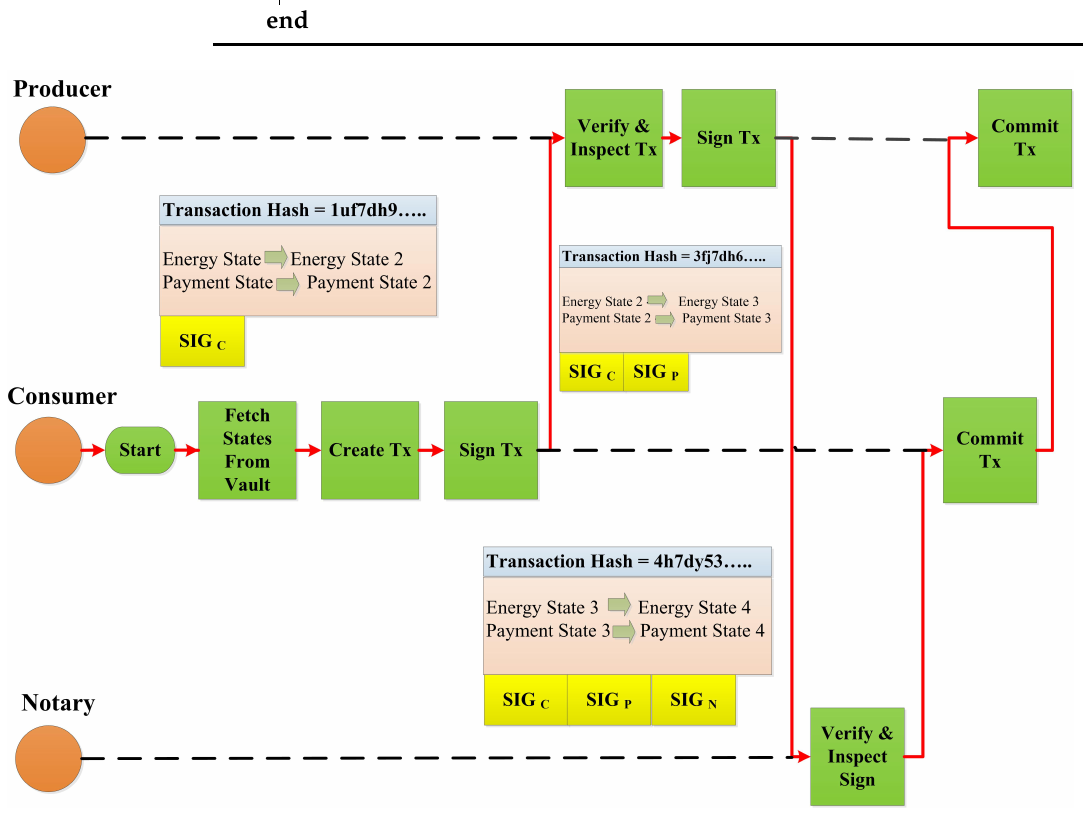
Figure 3. Energy request, transfer, and payment flow sequence in the proposed P2P energy trading framework with participant